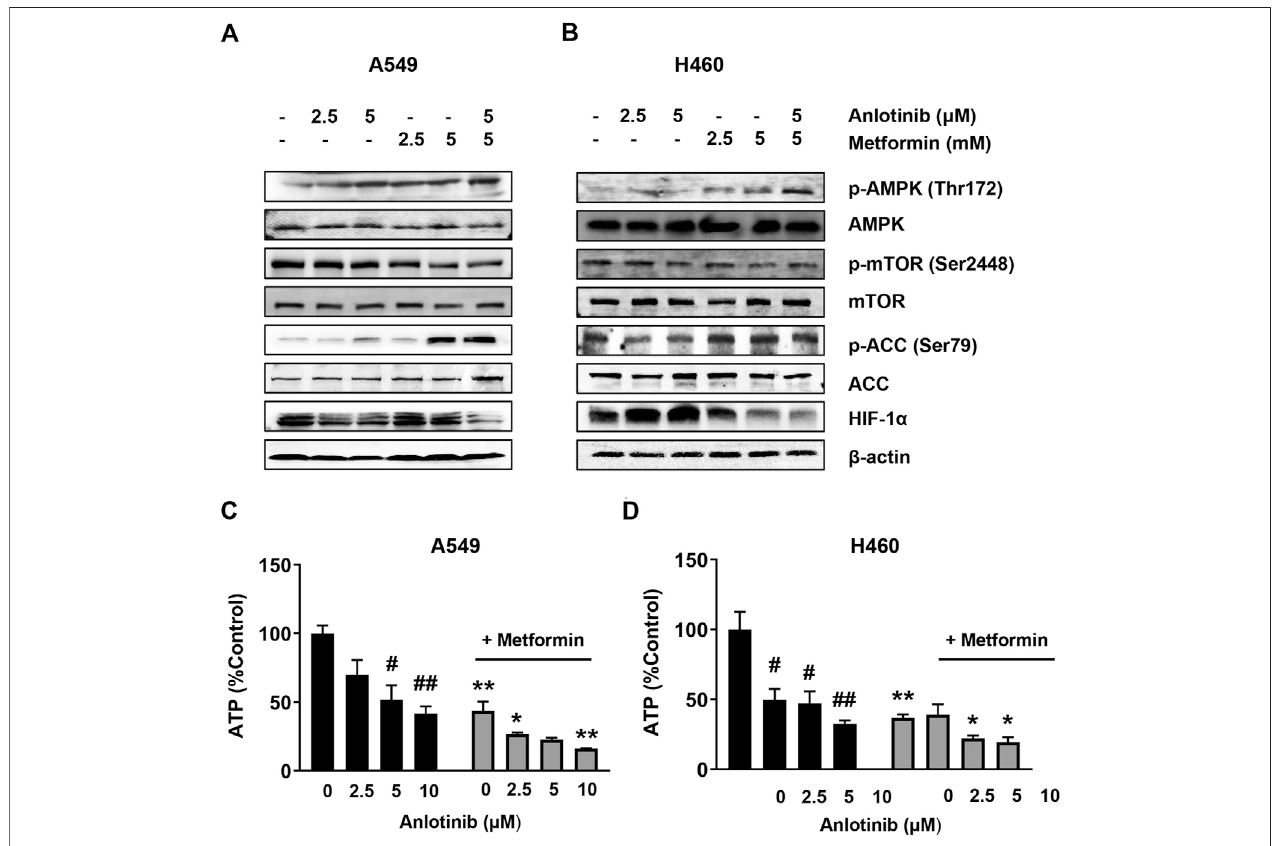
FIGURE 4 | Anlotinib in combination with metformin promotes the activation of AMPK and inhibition of mTOR. A549 (A) and H460 (B) cells were treated with the indicated concentrations of anlotinib, metformin, or both for 24 h. Cell lysates were harvested and immunoblotted with the indicated antibodies. A549 (C) and H460 (D) were exposed to the indicated concentrations of anlotinib alone or anlotinib and metformin (5 mM) for 24 h. Relative intracellular ATP levels were determined using an assay kit according to the manufacturer ’ s instructions. Data are presented as means ± SE from three independent experiments. Statistical signi fi cance was analyzed using unpaired Student ’ s t -test; * p < 0.05, ** p < 0.01 compared with anlotinib alone; # p < 0.05, ## p < 0.01 compared with the untreated control